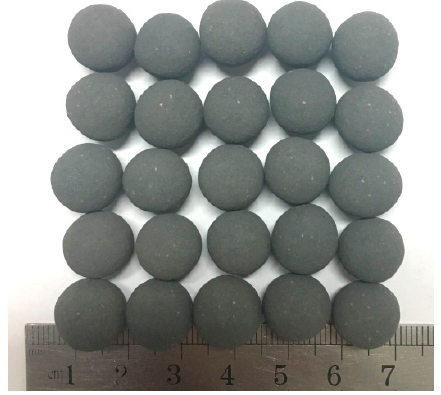
Figure 5. Picture of oxidized HCVTM pellets.